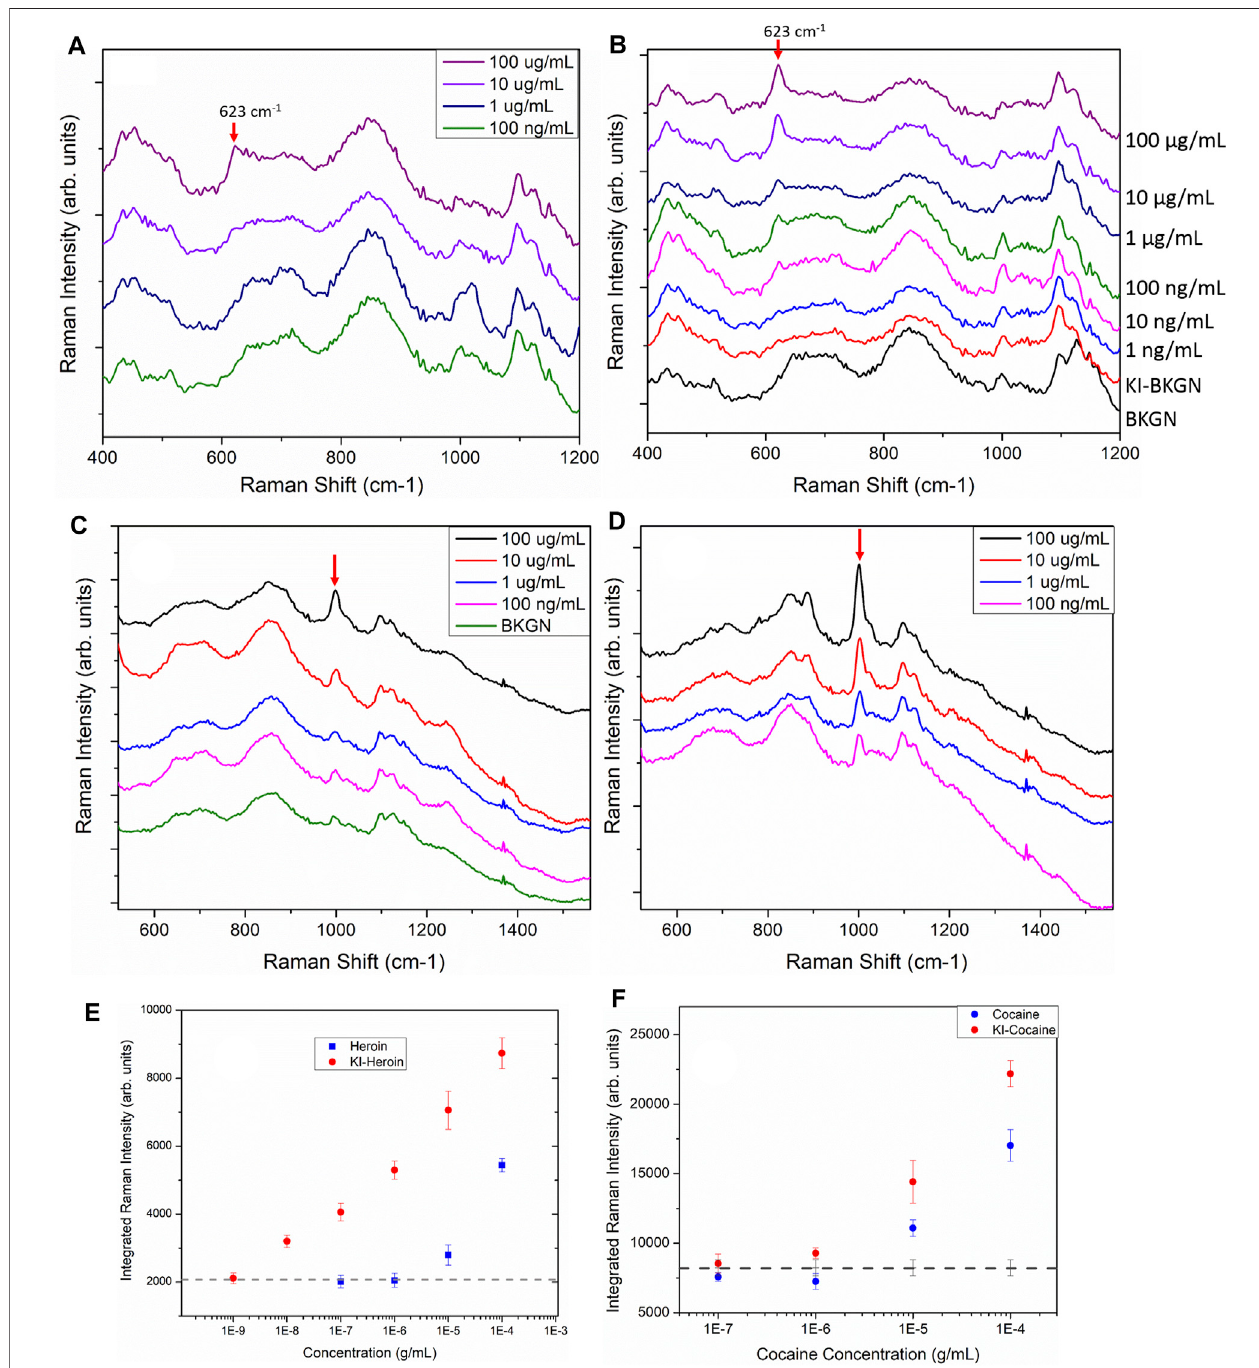
FIGURE 5 | SERS spectra of sensors directly exposed to heroin (A) and sensors fi rst functionalized with 1 mM KI before exposure to heroin (B) . The red arrows indicate the heroin vibration at 623 cm-1. Spectra have been offset forclarityand the tick increment on the y -axis is2,000 counts. (C) .SERS spectra ofsensors directly exposedtococaineofvariousconcentration.Thegreentrace(BKGN)isthespectrumobtainedfromablankSERSsensor. (D) .Sensors fi rstfunctionalizedwith1 mMKI followed by exposure to cocaine at various concentrations. Arrows indicates the cocaine vibration at 1,002 cm-1. Spectra have been offset for clarity and the tick increment on the y -axis is 2,000 counts. All spectra shown here were acquired with the ReporteR handheld Raman analyzer. Each of the spectra shown here is the average of 10 spectra taken from 10 random spots on each sensor. (E) The SERS integrated intensity of the 623 cm − 1 heroin vibrational band for sensors exposed to heroin. (F) The SERS integrated intensity of the 1,002 cm − 1 cocaine vibration from sensors exposed to cocaine. The dashed line in both C and D shows the averaged integrated intensity of the blank sensors and indicates the background signal level.